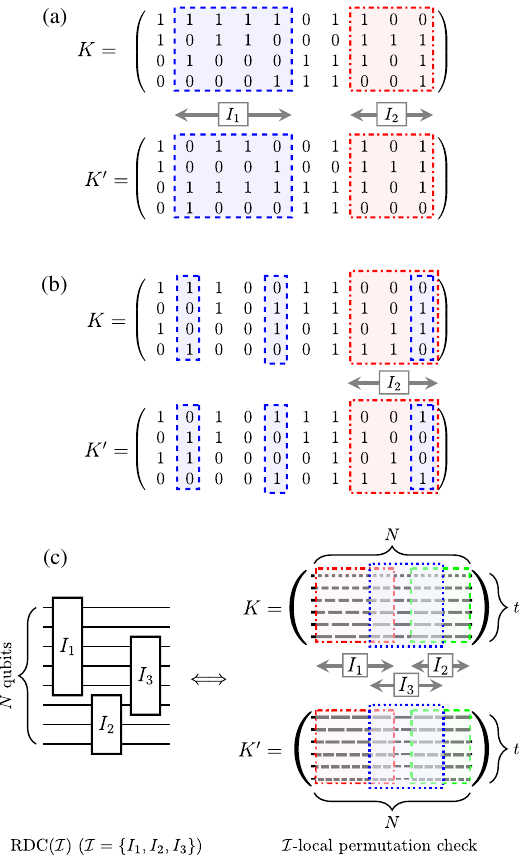
FIG. 1. (a),(b) Examples of local permutation check problems 1111 ; 0110 ; 1000 ; 0001 g is for t ¼ 4 and N ¼ 10 . In (a), K I 1 ¼ f a permutation of K 0 ¼ f 0110 ; 0001 ; 1111 ; 1000 g (blue dashed I 1 boxes). However, K is not a permutation of K 0 (red dash-dotted I 2 I 2 boxes). Hence, K is an f I 1 g -local but not an f I 2 g -local permutation of K 0 , also implying that K is not a row permutation of K 0 . In (b), K is identical to K 0 except the columns in the blue dashed boxes and is a 2-local permutation of K 0 . However, K fails to be a 3-local permutation of K 0 due to the last column (see, e.g., K and K 0 ). Panel (c) illustrates a relation between RDC ð I Þ and I 2 I 2 an I -local permutation check problem. As diagonal gates act on I 1 , I 2 , and I 3 , we first check if K is a f I 1 ; I 2 ; I 3 g -local permutation of K 0 . That is, we check the permutation relations between sets of rows in the red dash-dotted, green dotted, and blue dashed boxes. If K is f I 1 ; I 2 ; I 3 g -local but not a row permutation of K 0 , then h K; K 0 j E ½ð D Z Þ ⊗ t;t (cid:2)j K; K 0 i ¼ 1 D Z ∼ RDC ð I Þ